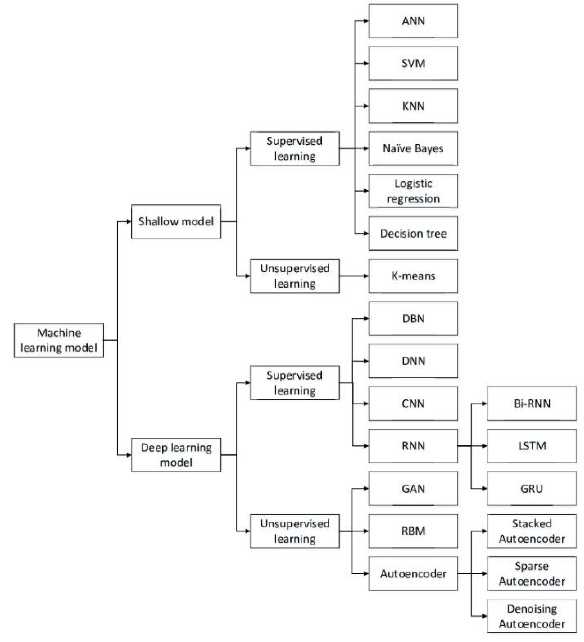
Figure 1 Machine learning algorithms [5].